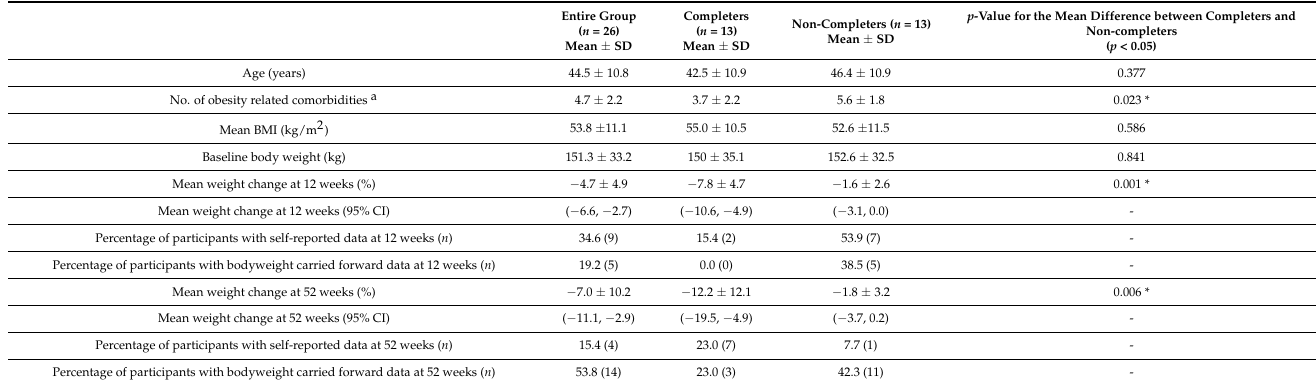
Table 1. Participant characteristics at baseline and weight loss outcomes at 12 and 52 weeks displayed as the entire group, completers, and non-completers.